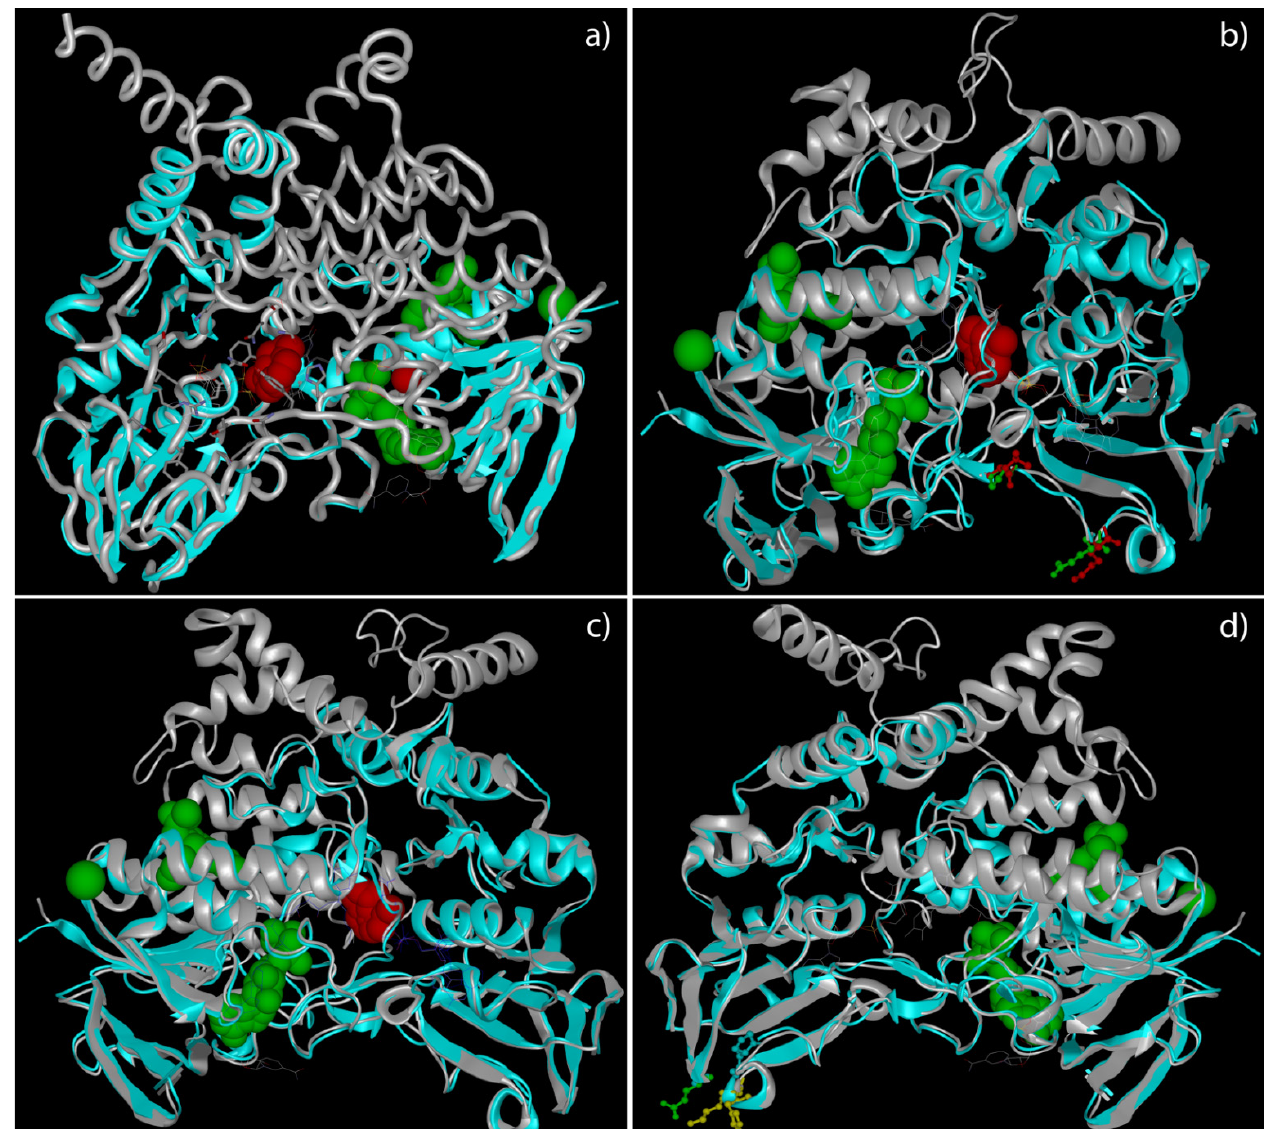
Figure 2. 3D structural models of FMO3 proteins in patients carrying non-sense variants. This panel highlights the predicted tertiary structure of FMO3 in patients 1 (Y331Stop) ( a ), 2 (P153L, E158K and P380fs) ( b ), 3 (P380fs) ( c ), and 4 (E308G and P380fs) ( d ). The grey tube/ribbons represent the wild-type structures, while the light blue the over imposed mutated ones. The green spheres represent the predicted ligands/coenzymes/cofactors exclusive of wild-type FMO3 (ADP, Na, and TMA), while the red spheres the predicted ones exclusive of different truncated FMO3 (Indole, Mg, and TMA; exceptions are represented by patient 3, who does not present the Mg, and by patient 4, who does not present any exclusive ligand compared to wild-type form of FMO3 ). Lateral chains of amino acids involved in missense variants are represented in green for the wild-type allele and in red for the mutated one. Yellow chains are characteristics of amino acids nearest to mutated ones.